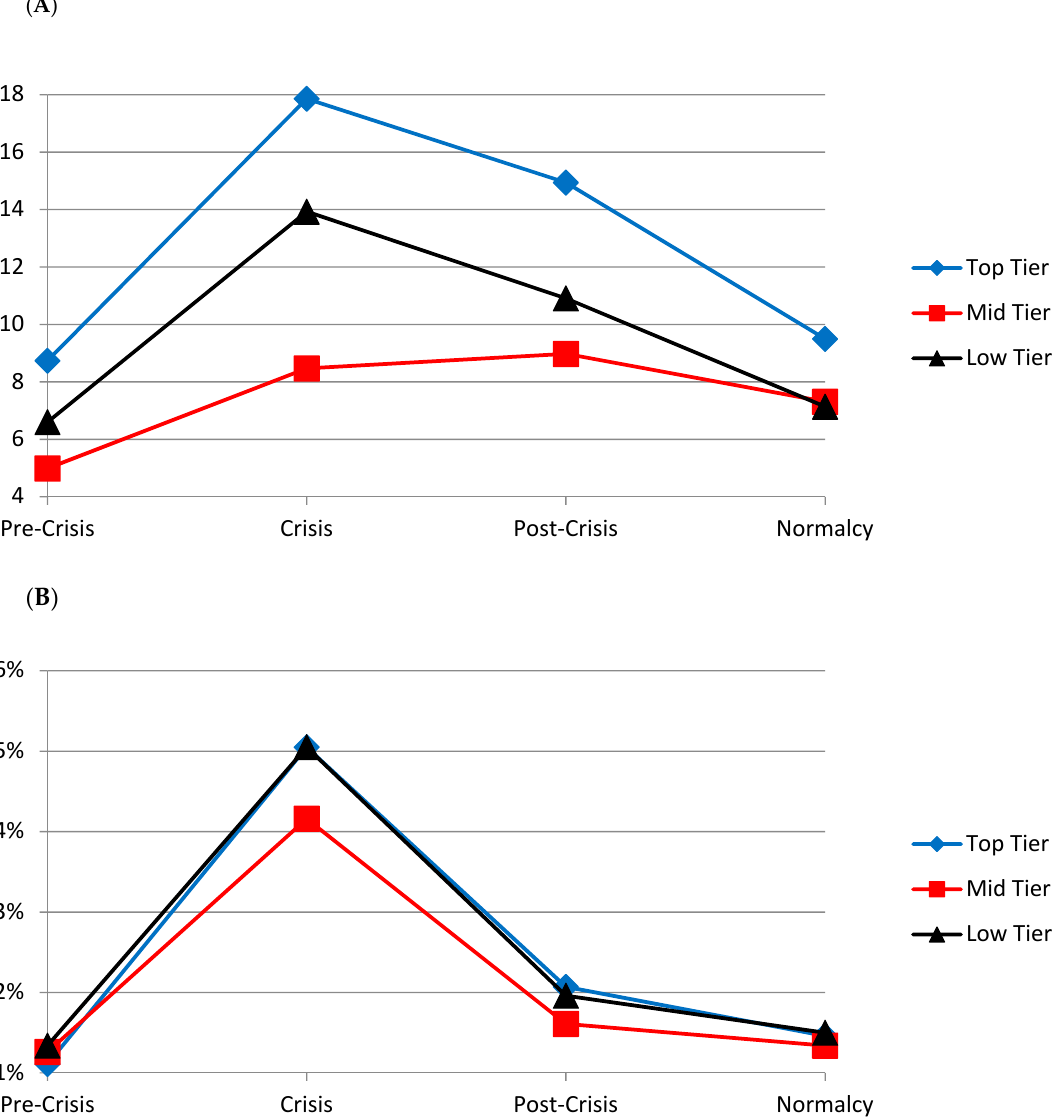
Figure 6. ( A ) Leverage. ( B ) Volatility. Notes: Top-Tier: JPMorgan Chase, Bank of America, Citigroup, and Wells Fargo; Mid-tier: Bank of New York Mellon, State Street, US Bancorp, and PNC Financial Services Group; Low-tier: Capital One Financial, BB&T, SunTrust Banks, and Regions Financial. Pre-crisis: 2005–2007; Crisis: 2008–2010; Post-Crisis: 2011–2013; Normalcy: 2014–2016. Leverage = (Book Assets − Book Equity + Market equity)/Market Equity. Volatility is the standard deviation of daily stock returns. Other than market data, all other items are book values from published annual reports.